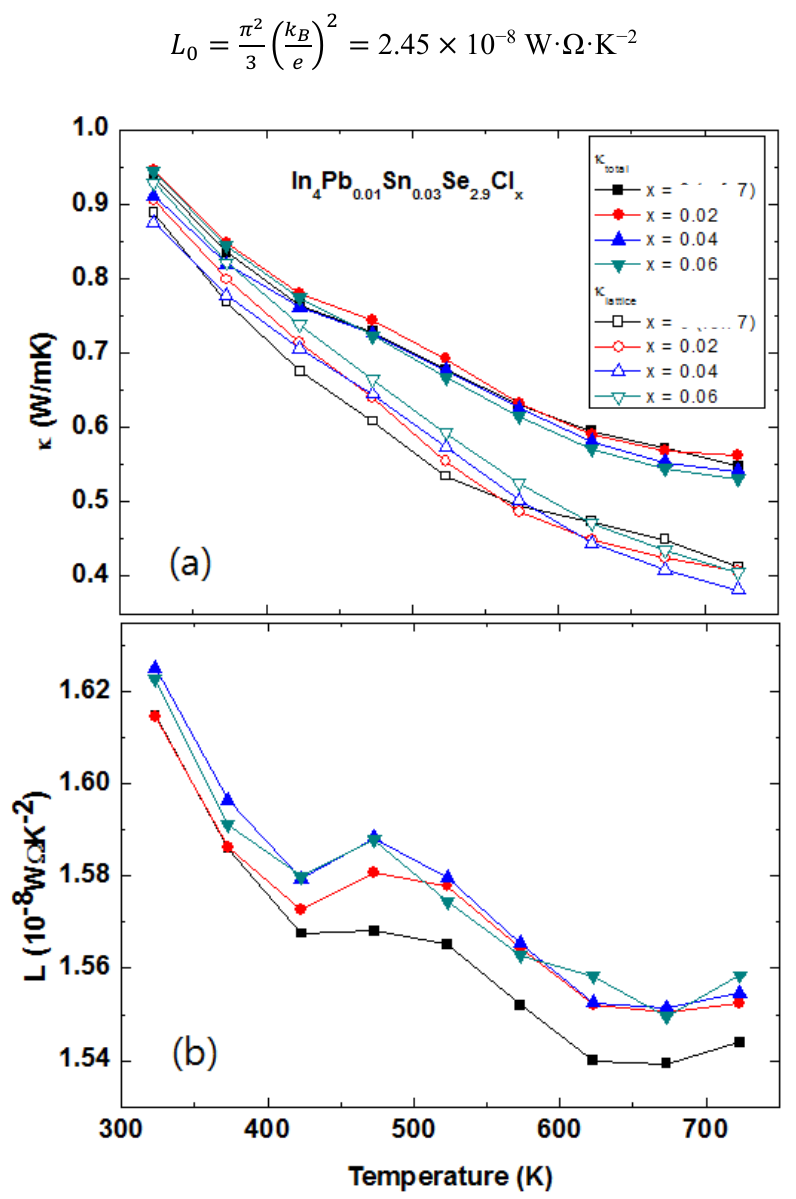
Figure 24. Temperature-dependent total thermal conductivity κ tot (closed symbols), lattice thermal conductivity κ ph ( a ), and Lorenz number L ( T ) ( b ) of the In 4 Pb 0.01 Sn 0.03 Se 2.9 Cl x ( x = 0.0, 0.02, 0.04, and 0.06) polycrystalline compounds [48]. However, the Lorenz number is incorrect in correlated metal and many degenerated